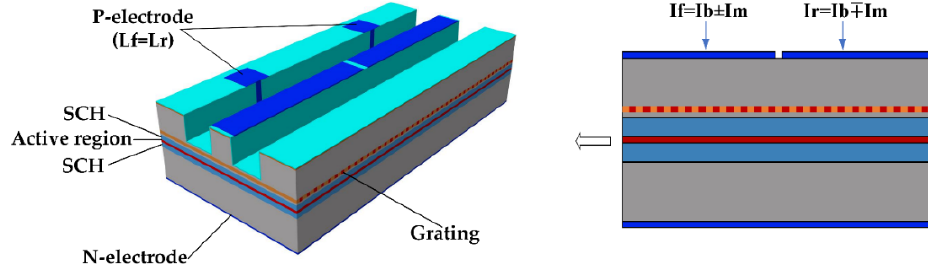
Figure 1. Schematic structure of the dual-sectional PPM-DFB laser.